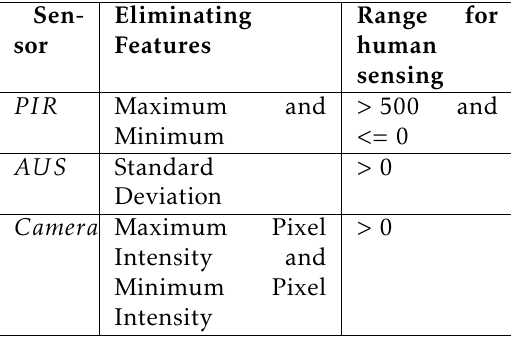
Table 4. Eliminating features and their specified ranges for PIR sensors, AUS and Camera for Experiment 2